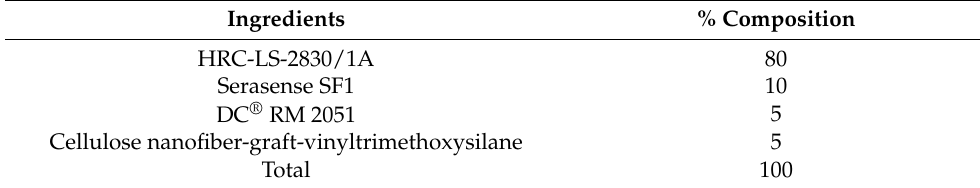
Table 3. Composition of component A in the elastic artificial skin.